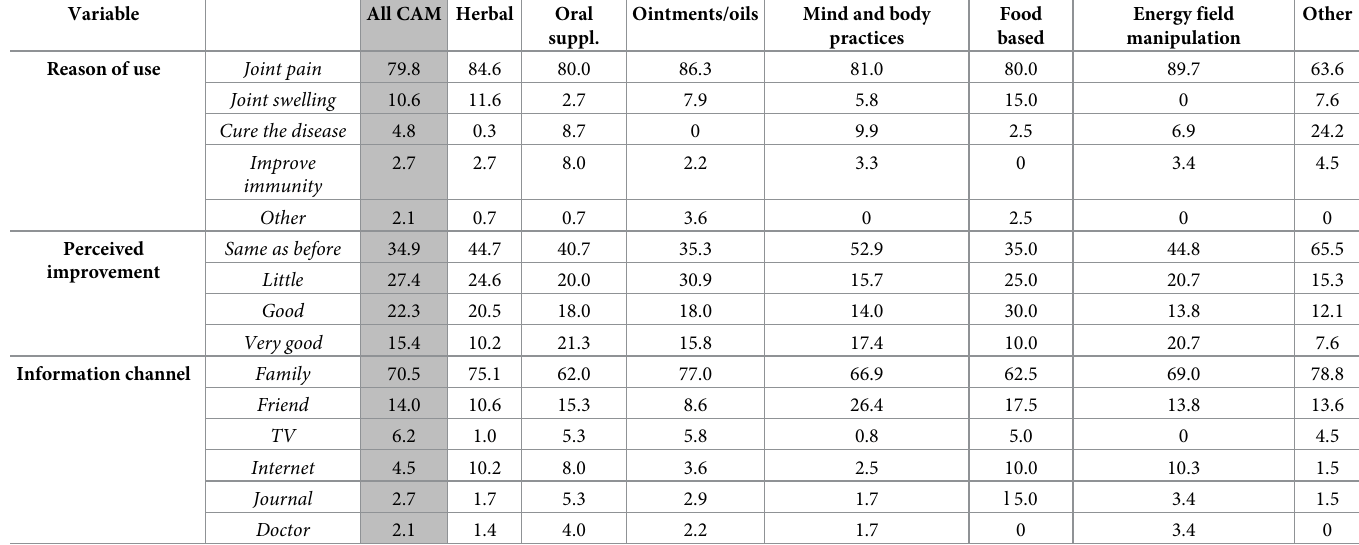
Table 4. Patient rationale on the use and effect of CAM.